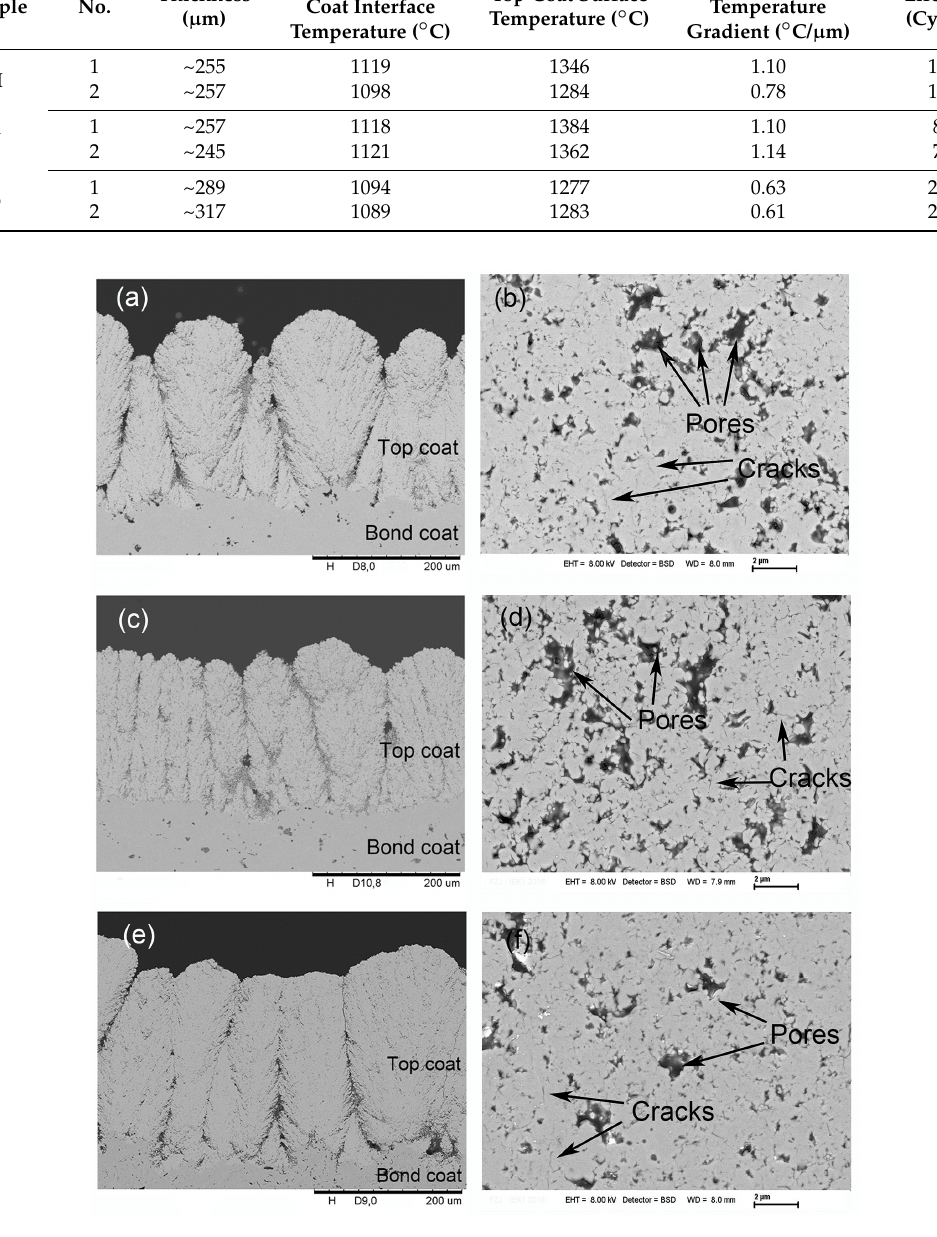
Figure 7. Cross ‐ section SEM images for as ‐ sprayed YSZ top coats: ( a ) Sample M, ( c ) Sample N, ( e ) Sample O; and the detailed microstructure within columns: ( b ) Sample M, ( d ) Sample N, and ( f ) Sample